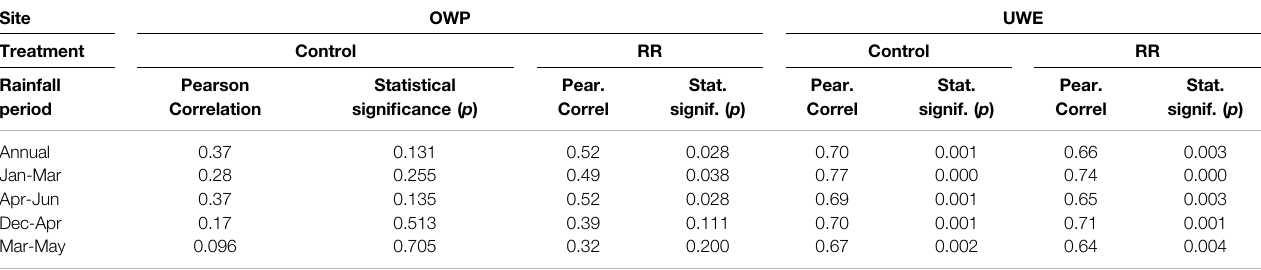
TABLE 3 | Correlations between total annual biomass (g m − 2 ) and rainfall (mm) at UWE and OWP for Control and Reduced Rainfall (RR) plots. n (cid:2) 18. Site OWP Treatment